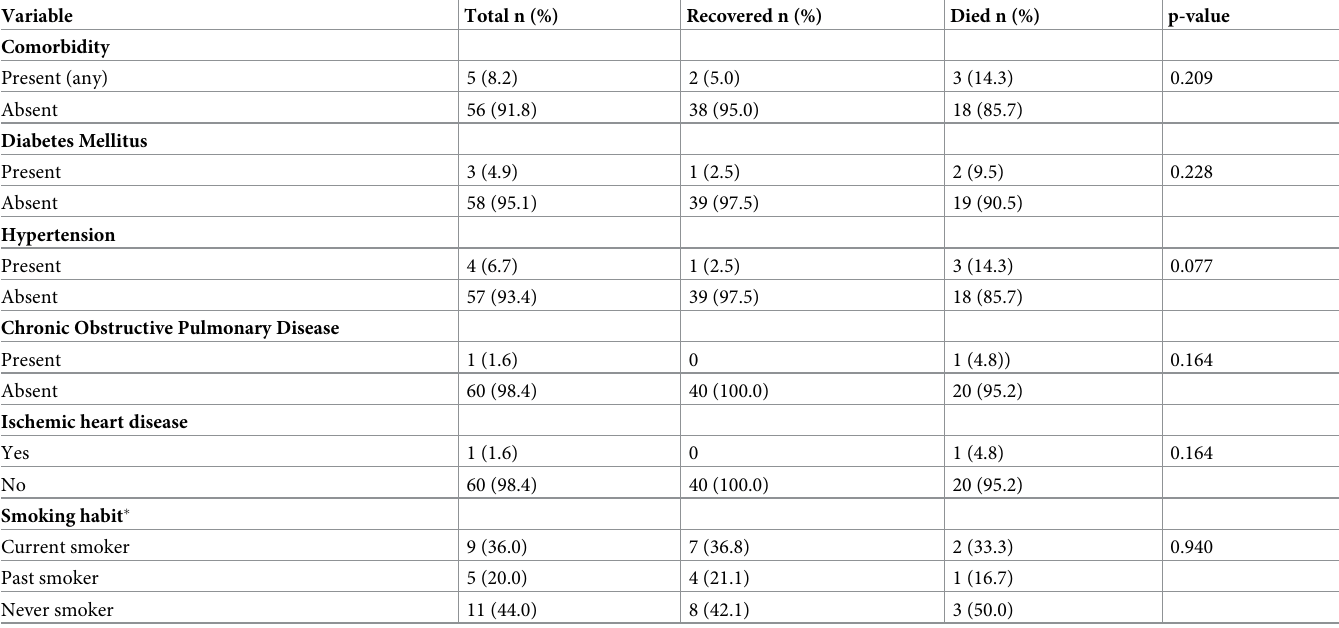
Table 2. Comorbidity and smoking habit of the patients (n =